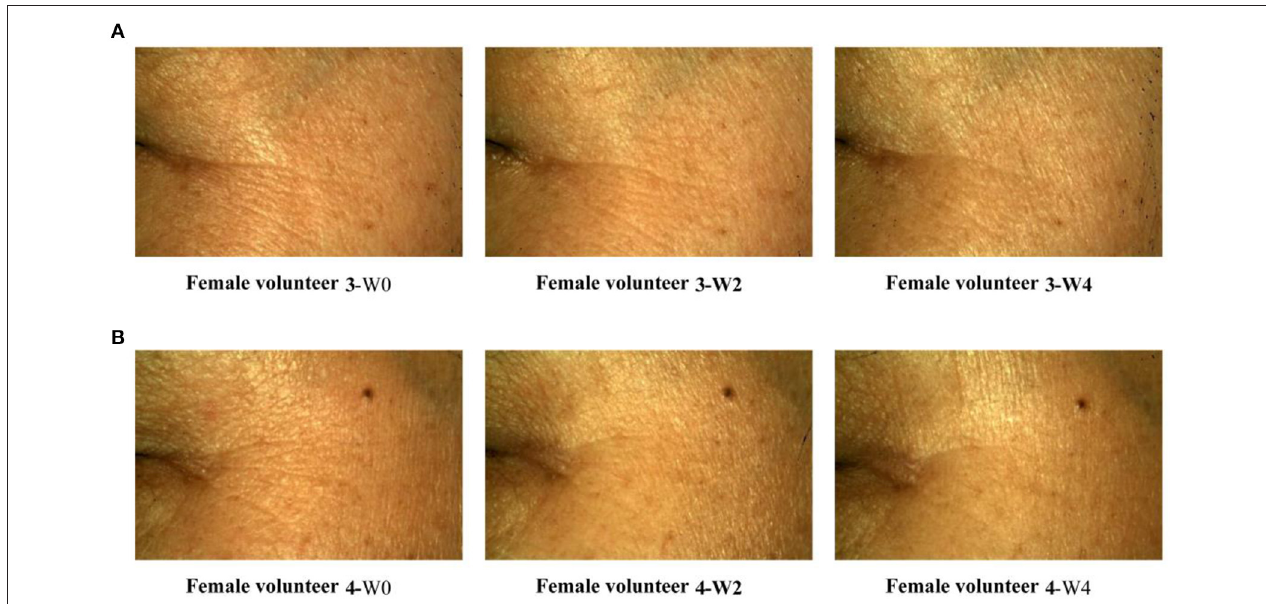
FIGURE 5 | Primos crow’s feet image legend. (A) Case 1: the crow’s feet of volunteer 3 were observed at 0, 2, and 4 weeks; (B) Case 2: the crow’s feet of volunteer 4 were observed at 0, 2, and 4 weeks.